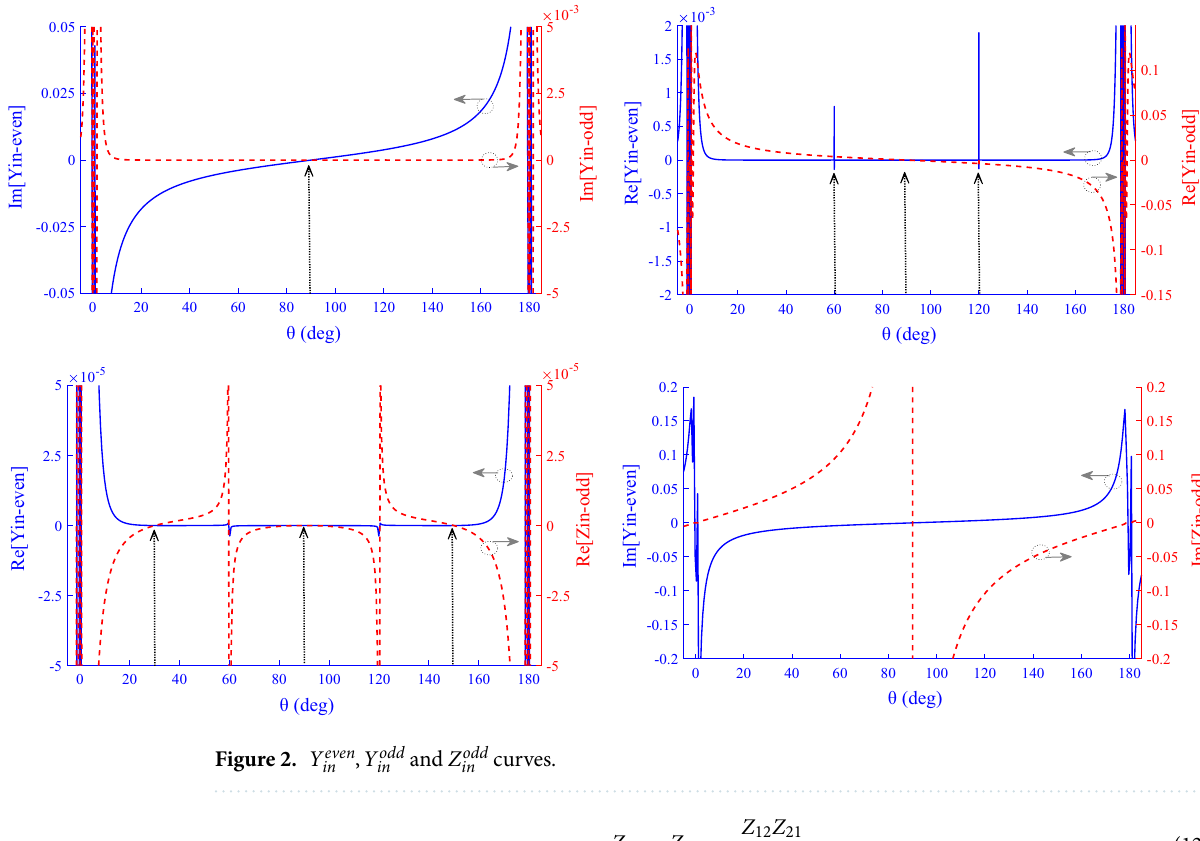
Figure 2. Y even in , Y odd in and Z odd in